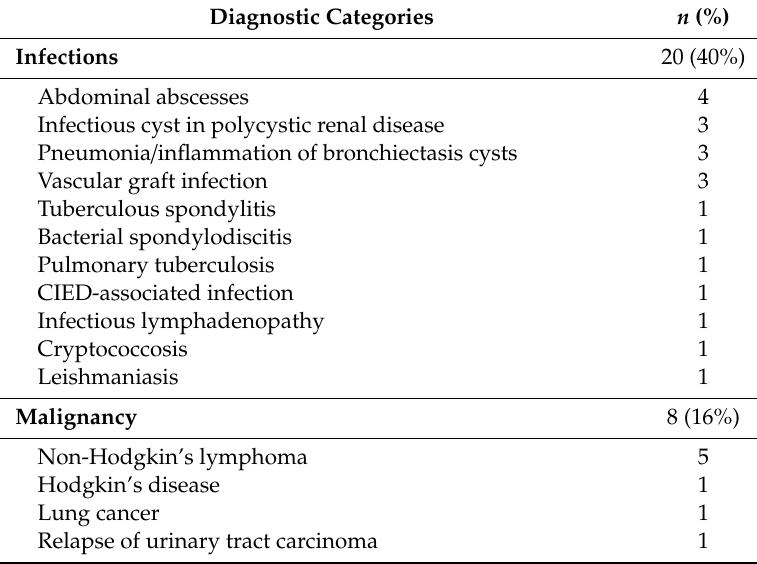
Table 3. Final diagnoses of 50 patients with fever of unknown origin